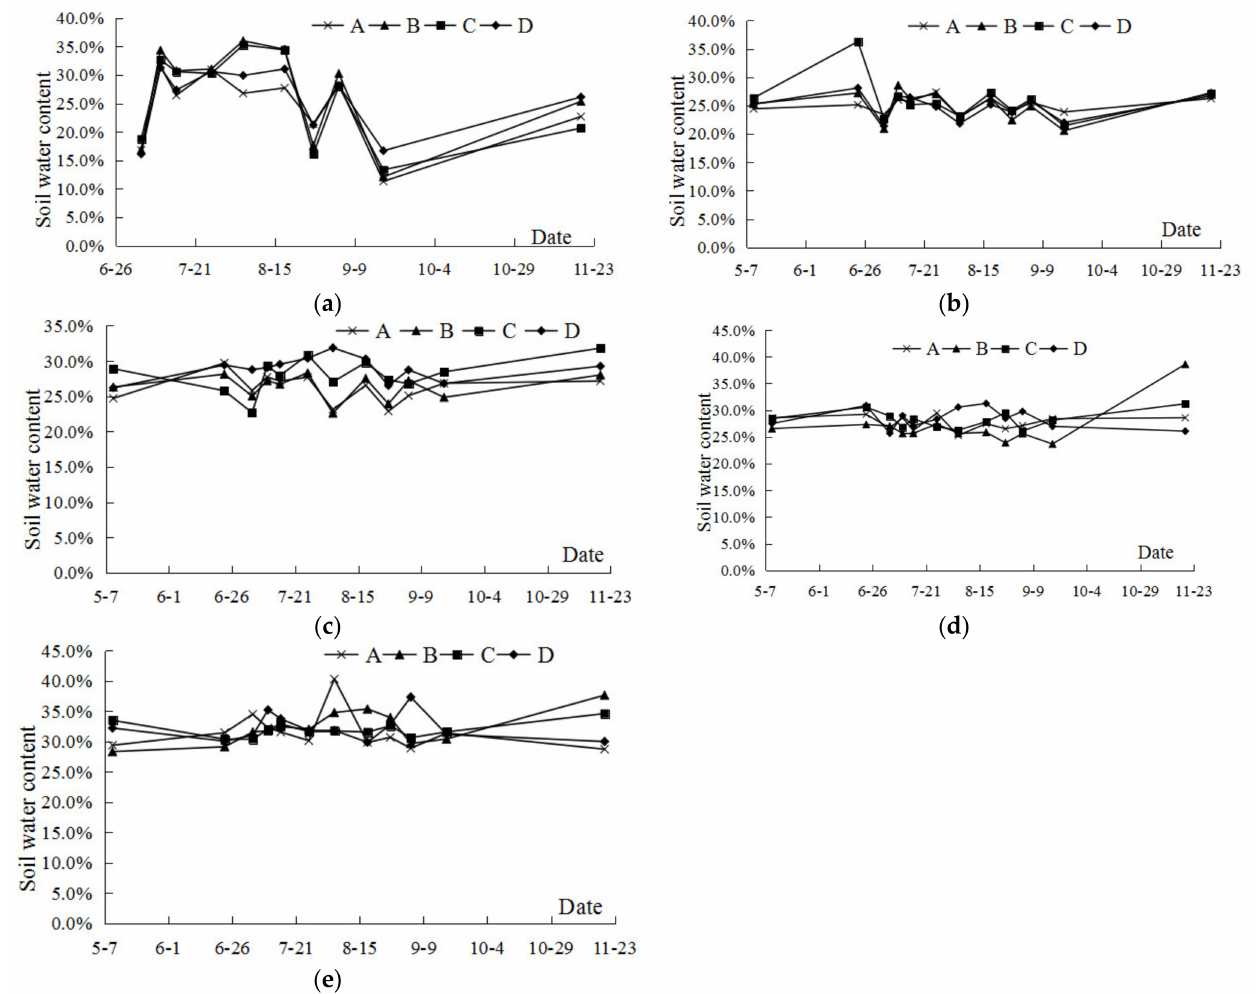
Figure 3. Variation in the soil water content in the different layers during the cotton growth period in the field in 2008. ( a ) Soil water content at the surface; ( b ) Soil water content in the 20 cm layer; ( c ) Soil water content in the 40 cm layer; ( d ) Soil water content in the 60 cm layer; ( e ) Soil water content in the 80 cm